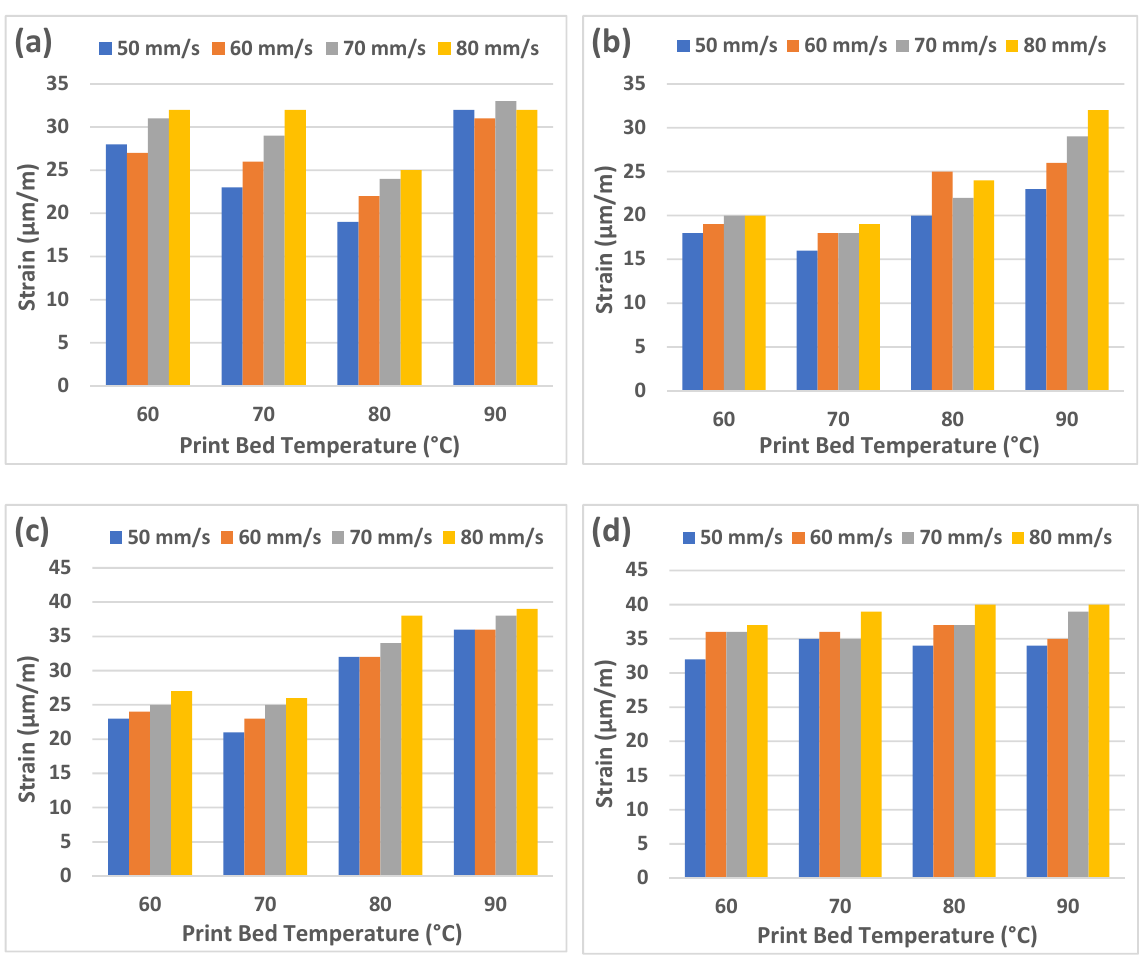
Figure 5. Results from strain measurement at different nozzle temperatures: ( a ) 180 °C; ( b ) 190 °C; ( c ) 200 °C; ( d ) 210 °C.